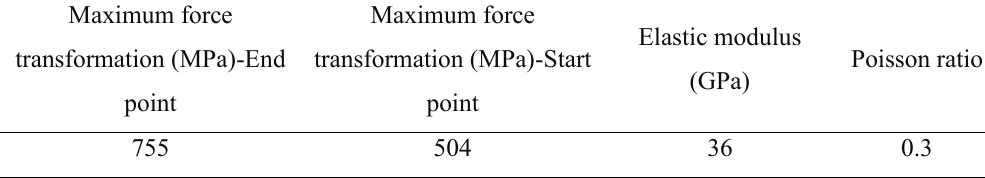
Table 2: Mechanical properties applied to computer models [14, 19] Table 2. Mechanical properties applied to computer models [14,